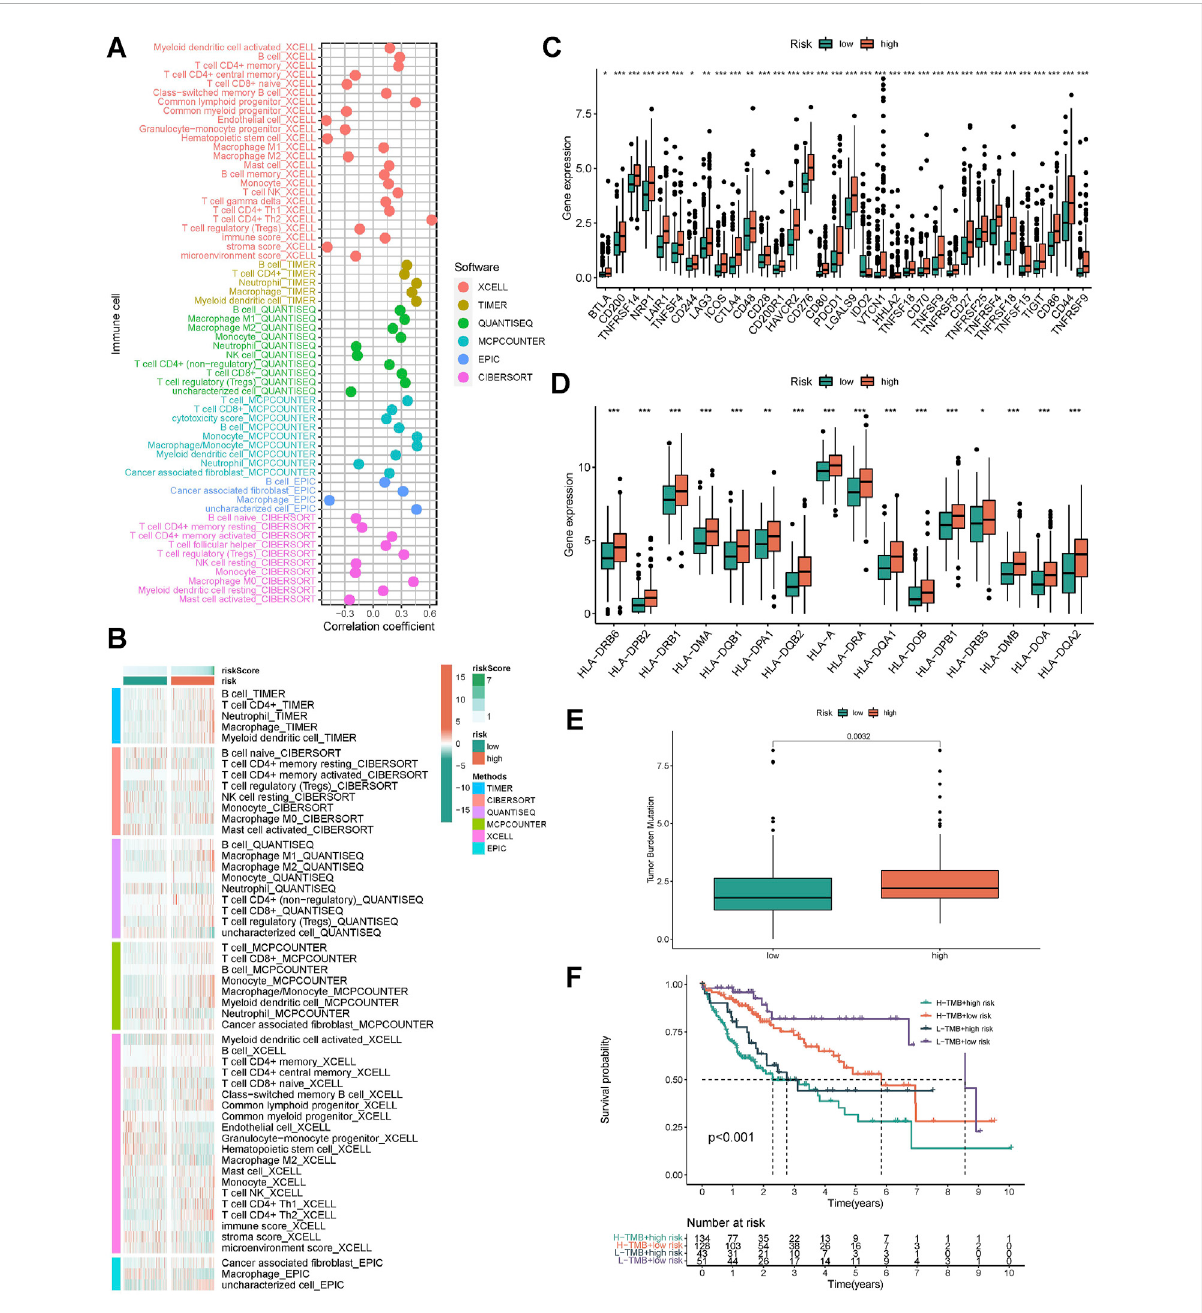
FIGURE 6 Characteristics of immune microenvironment in different risk groups. (A) The heat map showed correlation between risk score and immune function score. (B) The heat map showed differences in immune function of different risk groups. (C) The box plot showed differences in immune checkpoint mRNA expression of different risk groups. (D) The box plot showed differences in HLA mRNA expression of different risk groups. (E) The box plot showed differences in TMB score of different risk groups. (F) Survival analysis by combining TMB score and risk score. * p < 0.05, ** p < 0.01, *** p <